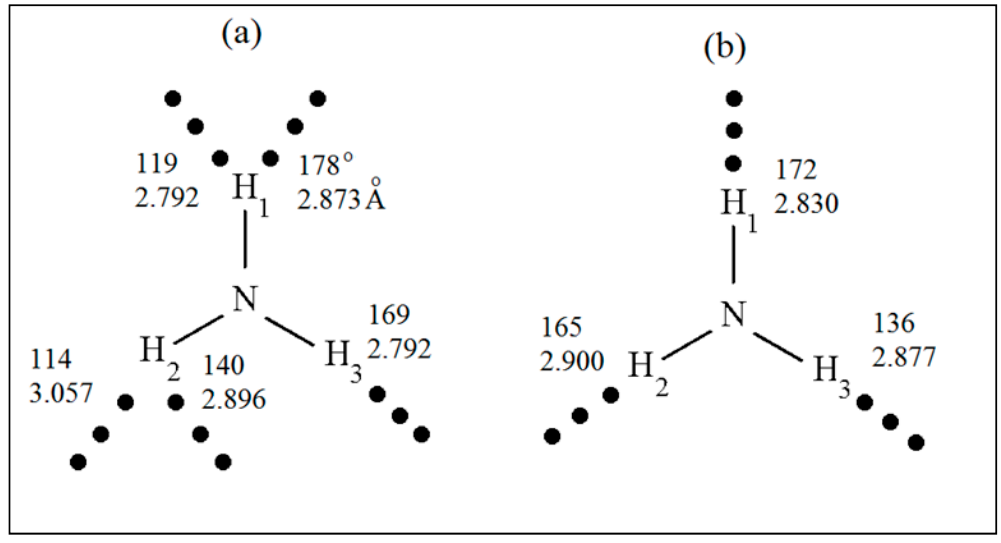
Figure 1. Representation of NH3+ group in ( a ) monoglycine nitrate and ( b ) mono- L -alaninium nitrate showing the hydrogen bonds with their respective lengths and angles.